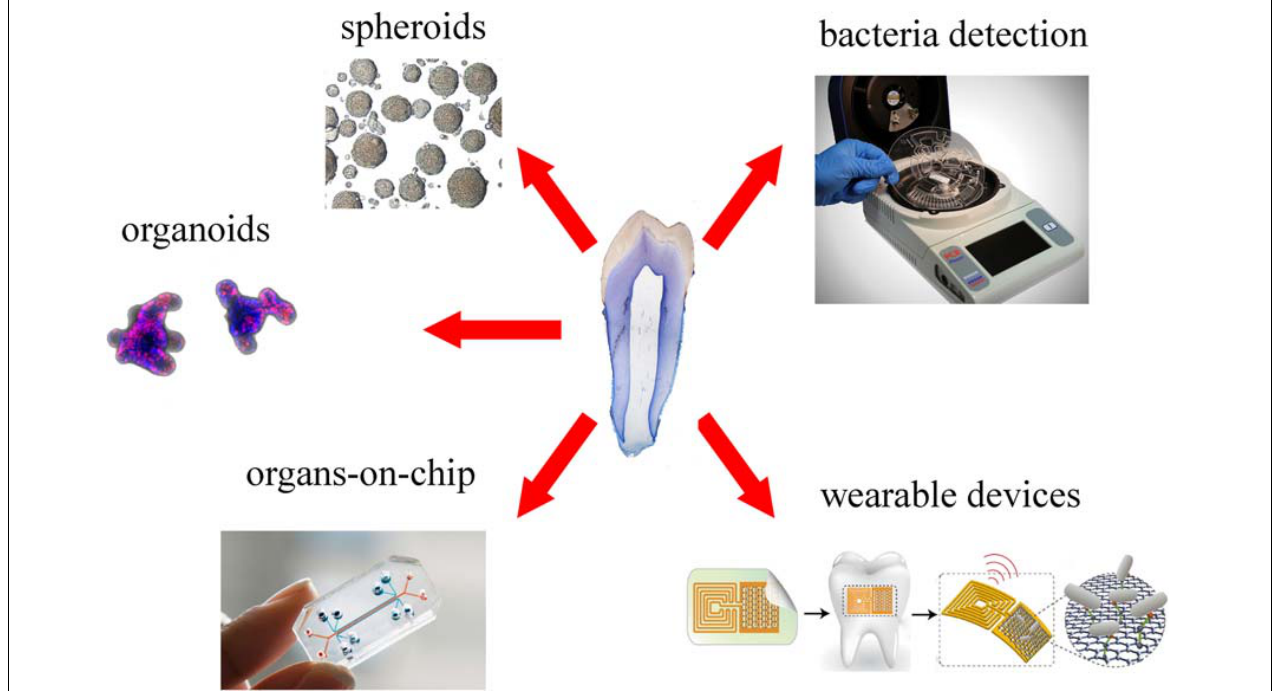
FIGURE 4 | Overview of new platforms for tooth modeling, drug discovery and diagnostics. From top right clockwise: LabDisk systems for bacteria detection (adapted from Czilwik et al., 2015) graphene-based wearable sensors (adapted from Mannoor et al., 2012), organ-on-chip (Emulate©), organoids (courtesy of Dr. T. Valenta, University of Zurich), spheroids (adapted from Natsiou et al.,